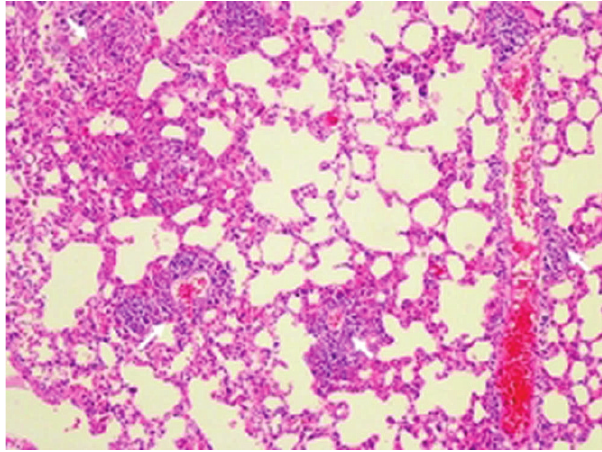
Figure 5 - Histopathological findings in the cigarette and biomass smoke-exposed group (Group IV). Parenchymal, peribronchial, and perivascular inflammation (arrow). (H&E,